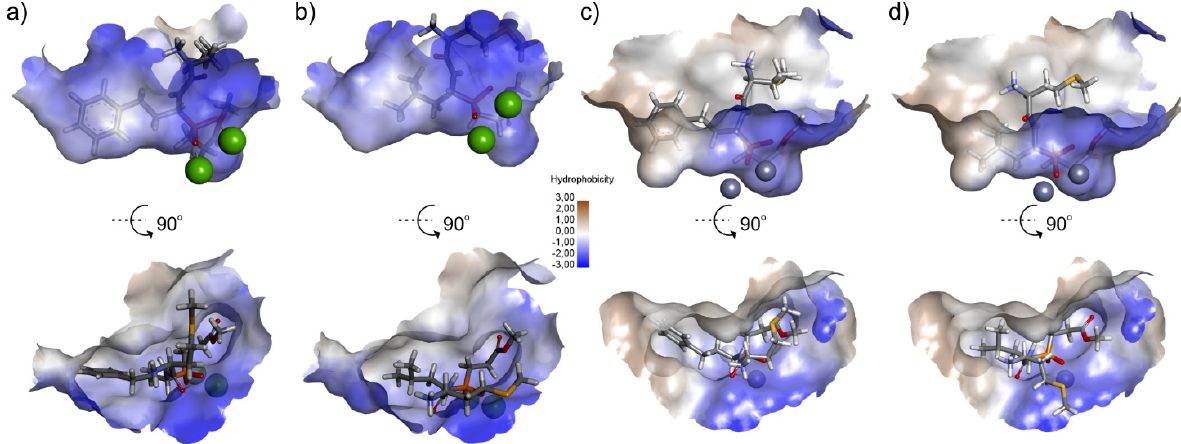
Figure 5. Alignment of ( a ) 1 - SR isomer and ( b ) 2 - SR isomer in the active site of SlLAP (PDB: 4KSI) , and ( c ) 1 - SR isomer and ( d ) 2 - SR isomer in the active site of BtLAP (PDB: 1LCP). Magnesium and zinc ions are shown, respectively, as the green and gray spheres. The surface of the active site is colored according to hydrophobicity.